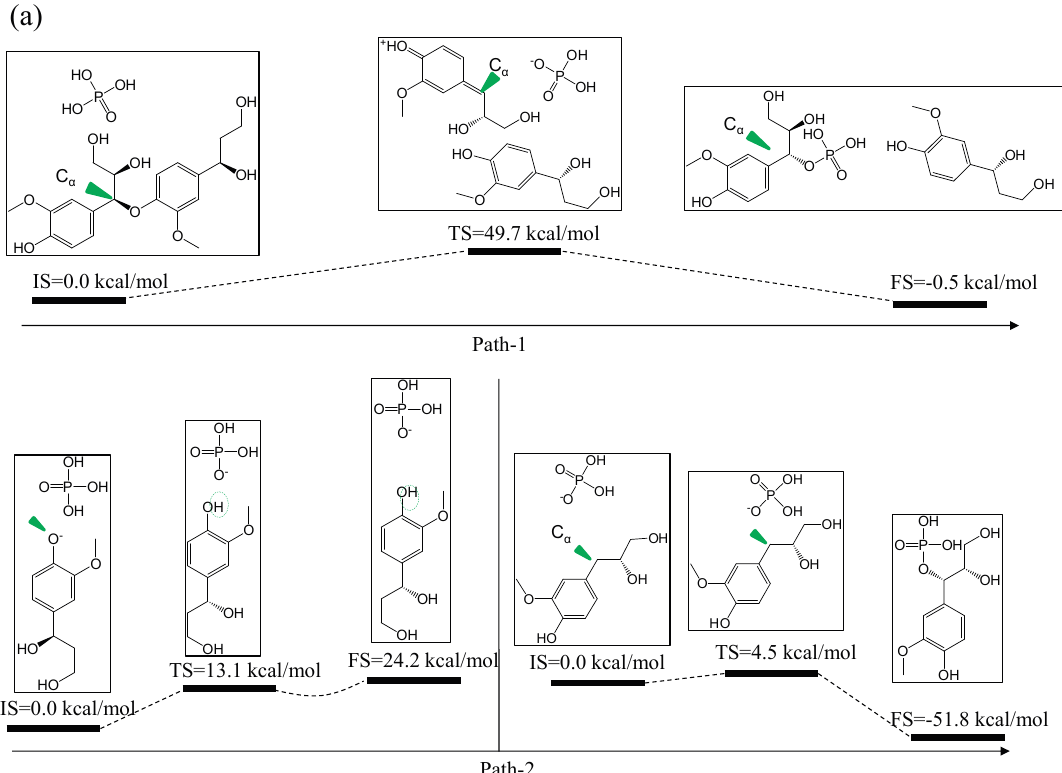
Figure 3. The calculated potential energy profiles for the direct one-step phosphorylation of lignin at ( a ) α -O- 4 linkage and at ( b ) β -O- 4 linkage, and the referenced two-step phosphorylation of the decomposed